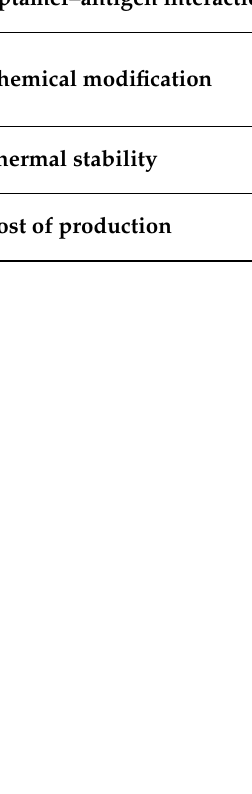
Table 2. Ongoing clinical trials using aptamers in either diagnosis or treatment of several